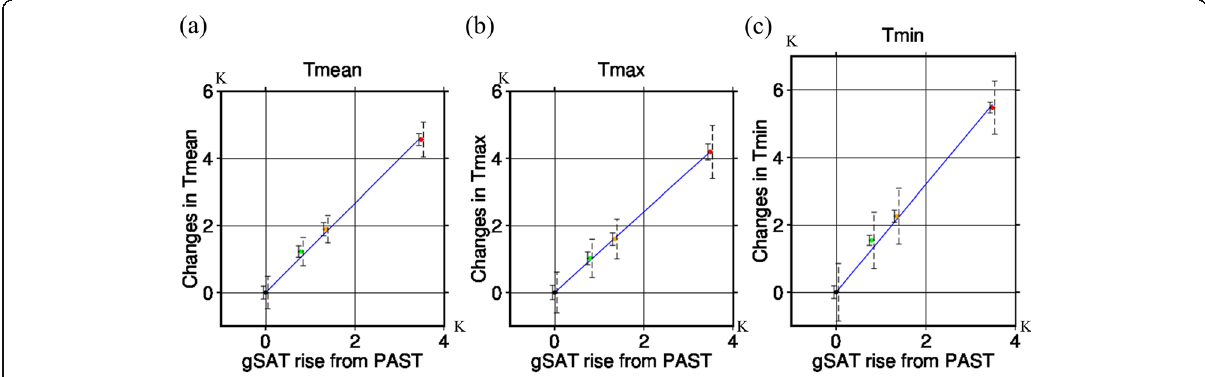
Fig. 6 Future changes in Tmean, Tmax, and Tmin. a Tmean, b Tmax, and c Tmin are averaged on all land grids on the Japanese Islands relative to those of PAST as a function of gSAT increases. The bars with solid line indicate standard errors of the ensemble mean, and the bars with dashed line indicate standard deviations. Linearly fitted line is shown in each panel. The black, green, yellow, and red circles indicate PAST, d1.5, d2, and d4,